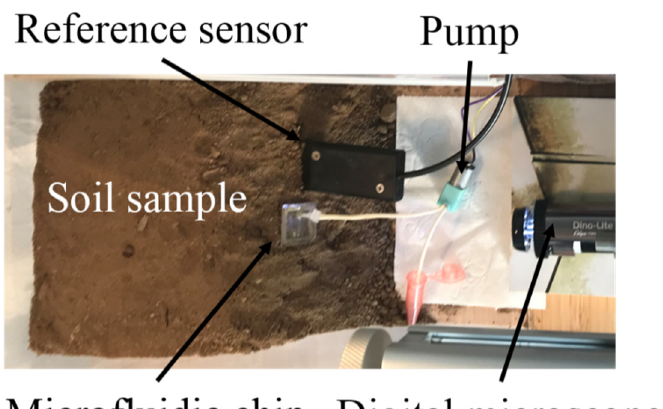
Figure 6. Characterization setup for soil-solution extraction unit. This garden soil sample was pre- pared in a plastic box (30 cm × 16 cm × 12 cm). The upper side of the device was pushed approxi- mately 5 mm into the soil.